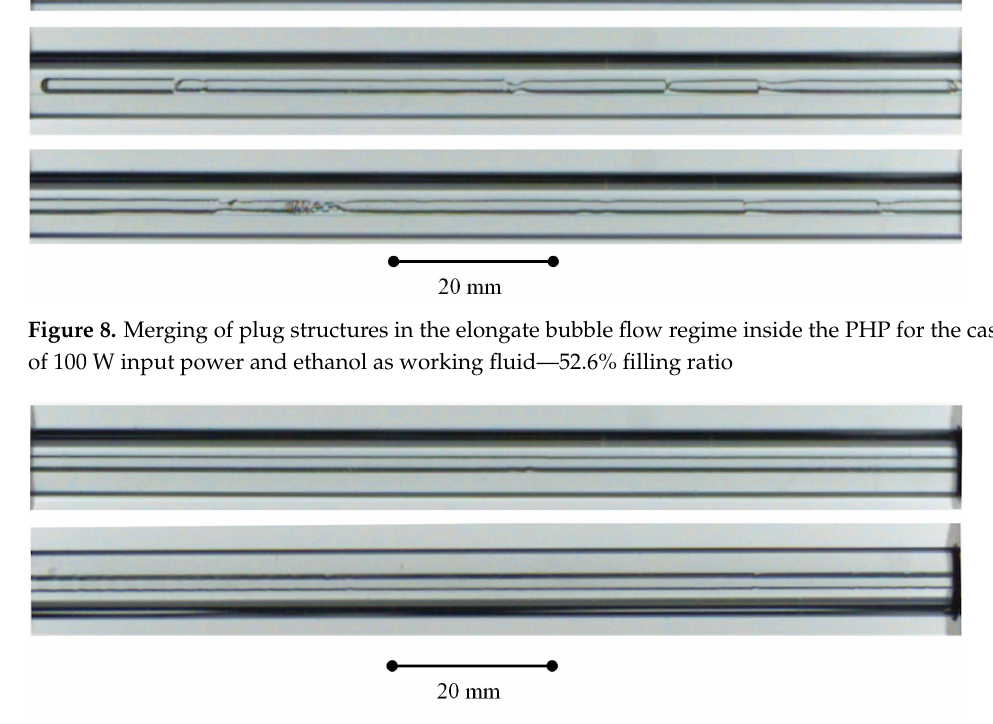
Figure 9. Annular flow regime inside the PHP for the case of 100 W input power and ethanol as working fluid—52.6% filling